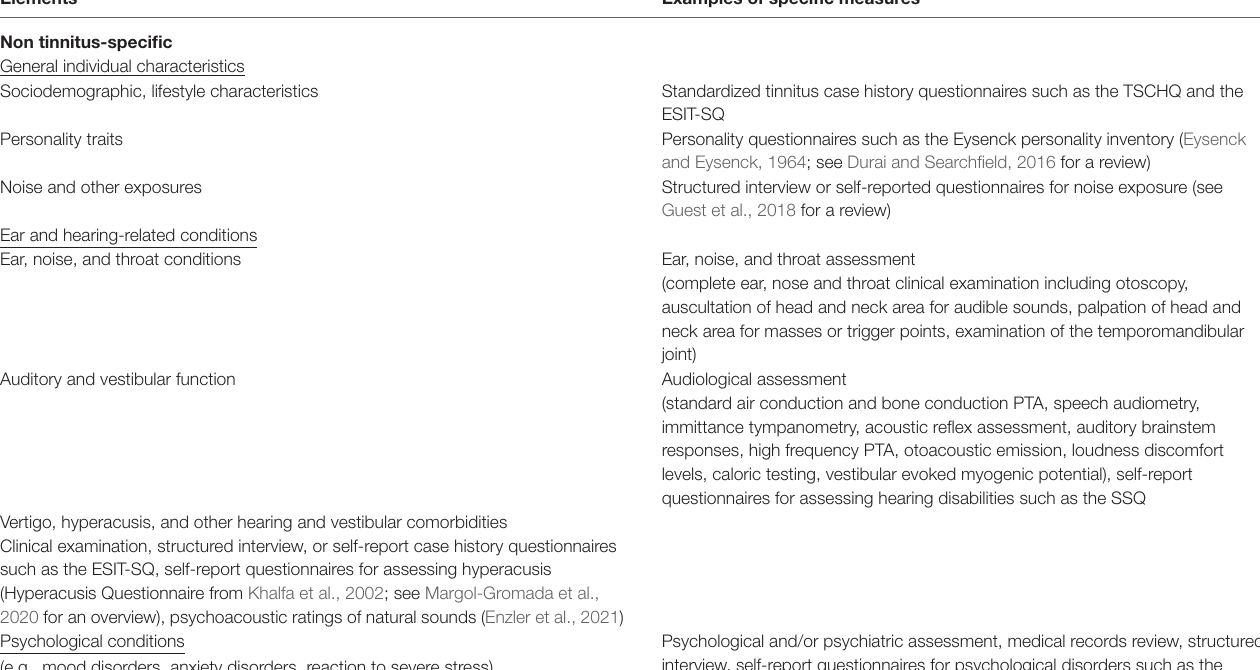
TABLE 1 | Overview of elements for tinnitus